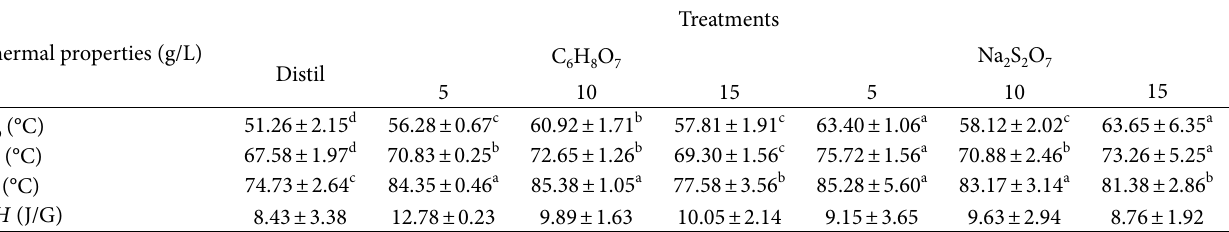
Table 4: Thermal properties of NSP flour.